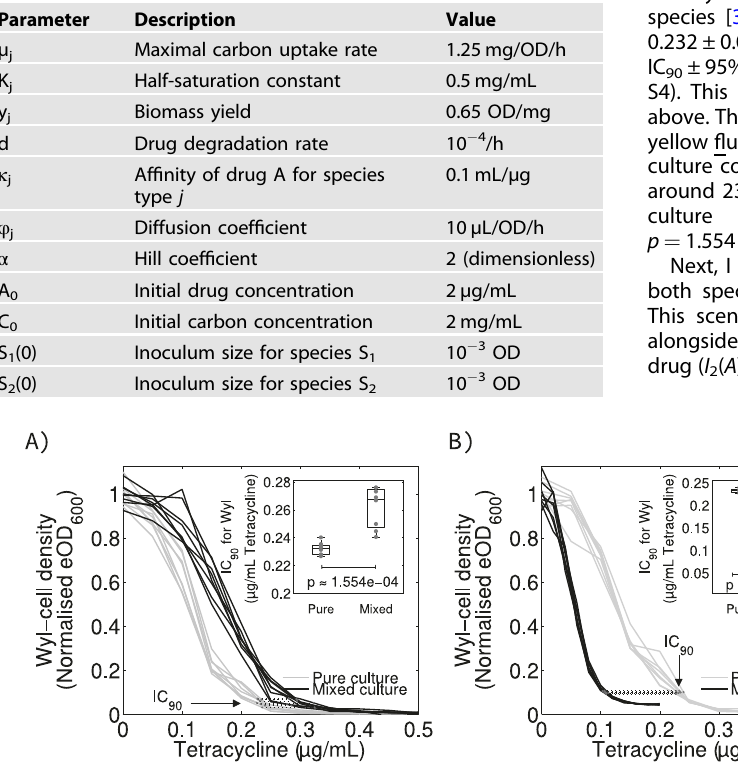
Fig. 2 Changes in drug ef fi cacy against sensitive Escherichia coli Wyl are consistent with theoretical predictions. A , B Change in normalised density of Escherichia coli Wyl as a function of tetracycline concentration, when Wyl grows in mixed culture with tetracycline- sensitive Salmonella typhimurium ( A ) and tetracycline-resistant Escherichia coli GB(c) ( B ). The change in density of Wyl growing in mixed culture is shown in black, with grey showing the change in density in pure culture. The IC 90 in each condition is shown as dots, red for mixed culture conditions and dark grey for pure culture, connected by a dotted line. Non-parametric, Mann – Whitney U-test between IC 90 s is shown in the inset. Raw data is shown as dots, whereas the boxes represent median (centre of the box), 25th, and 75th percentile of the dataset. The whiskers show the most extreme data points that are not outliers. C Theoretical change in S 1 -cell density with increasing antibiotic concentration in pure (grey) and mixed (black) culture conditions with neighbours that have different drug sensitivity. The plot represents